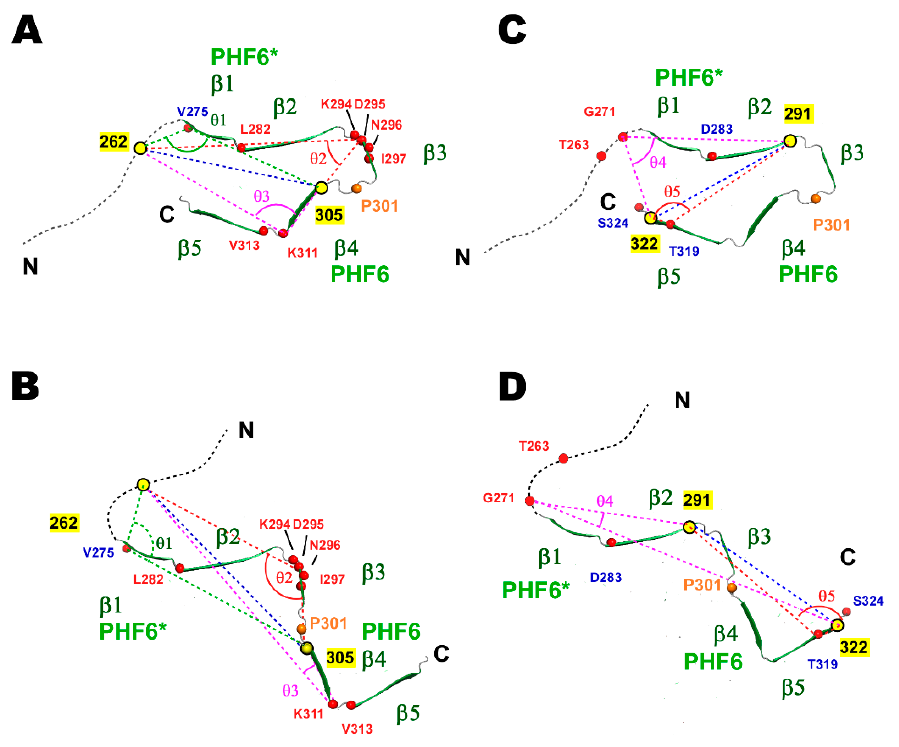
Figure 7. Model structures of TauF4 ∆ based on significant changes in the PRI rates between the wild-type and P301L mutant. Three and two representative residues are selected from TauF4 ∆ labeled at 262 and 305 and TauF4 ∆ labeled at 291 and 322, respectively, all of which showed significant changes in PRI rates for the P301L mutant. The structures are modeled from the heparin-induced tau filament structure (PDB ID: 6QJH) [19] to fulfill the presumed angle changes ( θ 1 – θ 5 ) suggested by the changes in the PRI rates. ( A ) A representative form of the wild-type TauF4 ∆ modeled based on the PRI rates for V275, N296 and K311 in the tau fragment with labeling at 262 and 305, and ( B ) also on the PRI rates for G271 and T319 in the tau fragment with labeling at 291 and 322. ( C ) A representative conformation similarly modeled based on the same set of data collected from the tau fragment labeled at residues 262 and 305, and ( D ) also for the tau fragment with labeling at 291 and 322 ( D